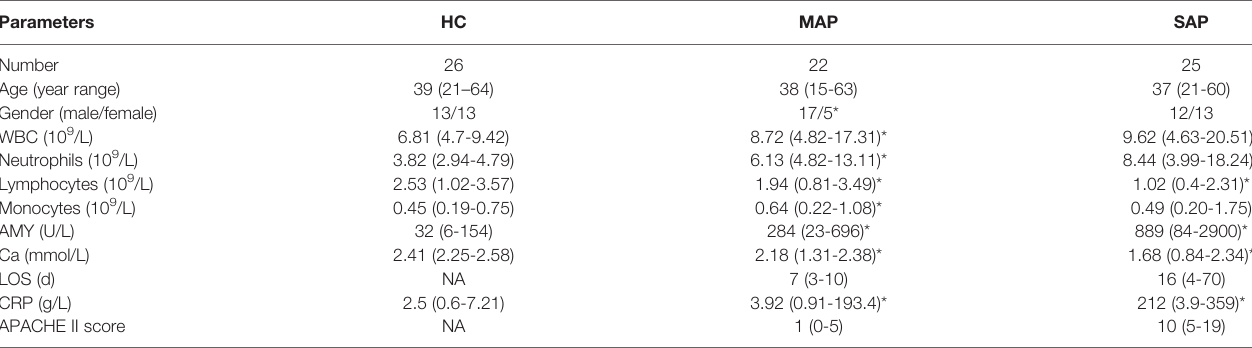
TABLE 1 | Demographic and characteristic of